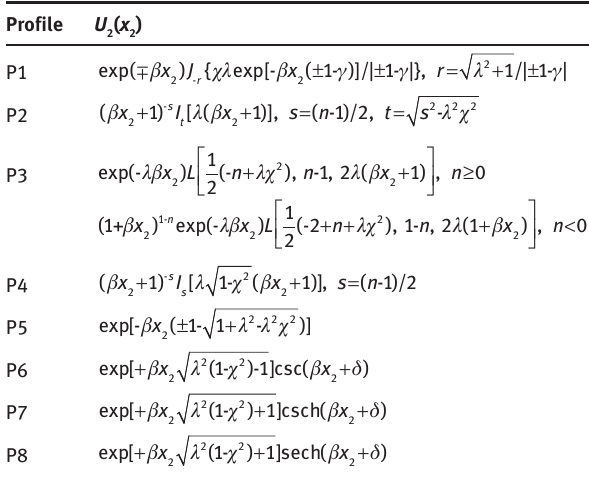
( x ) for the special inhomogeneity profiles. 2 2